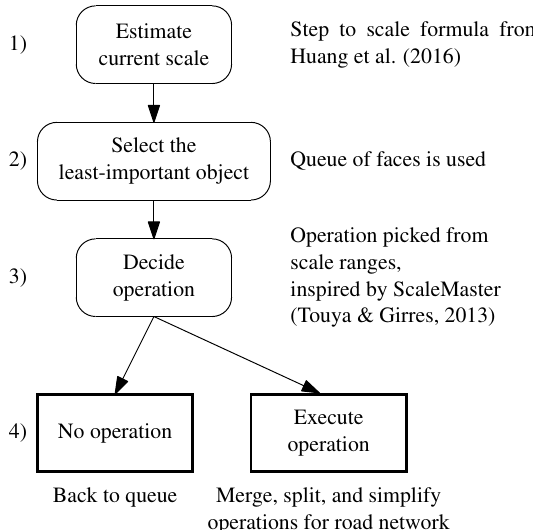
Figure 3. Outline of actions for one generalization step. During the phase for determining the compatibility value, a factor larger than 1 is used, when an object is in the same region as one of its neighbours (neighbour is more attractive). The regions make it possible to better steer what should happen for example in case of rural and urban areas, i.e. to prevent merges from rural to urban regions.